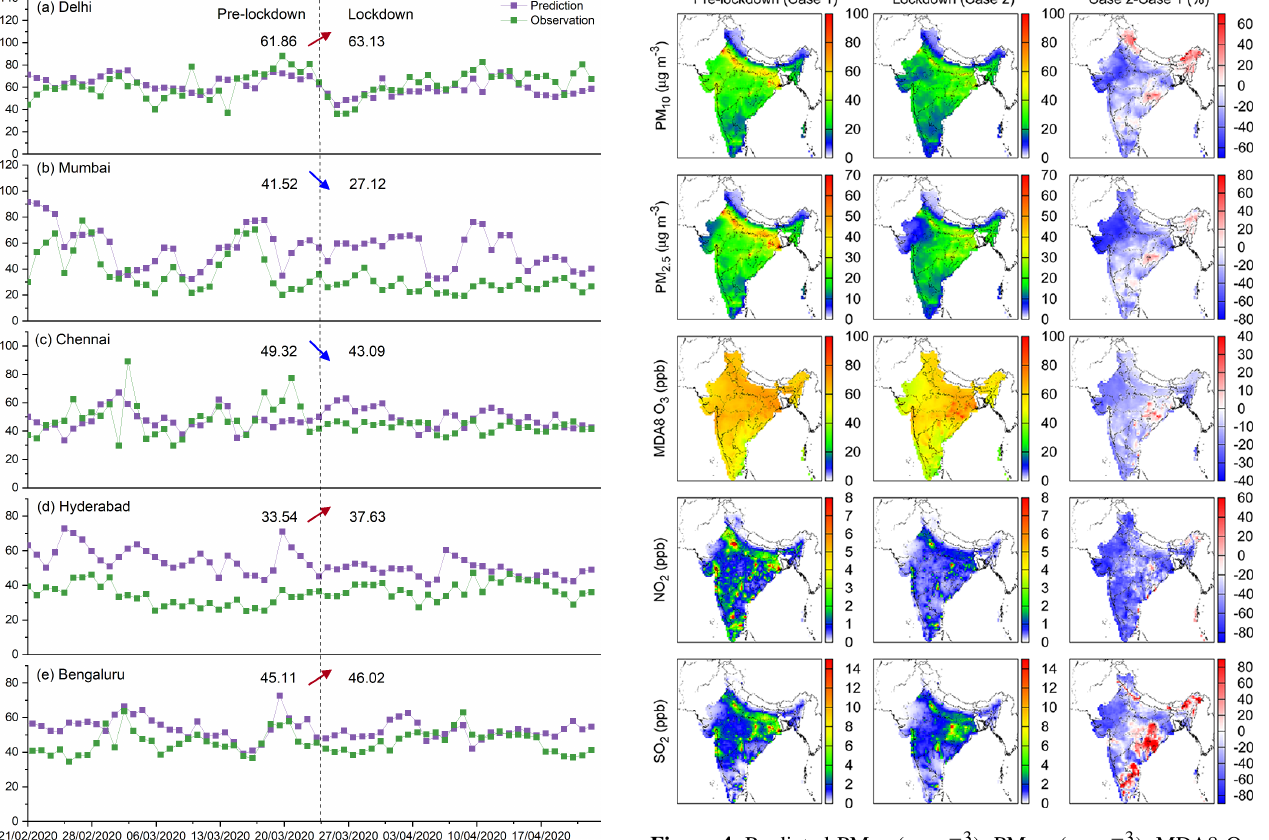
Figure 3. Comparison of predicted and observed MDA8 O 3 from 21 February to 24 April 2020 in Delhi, Mumbai, Chennai, Hyder- abad, and Bengaluru. The unit is ppb.